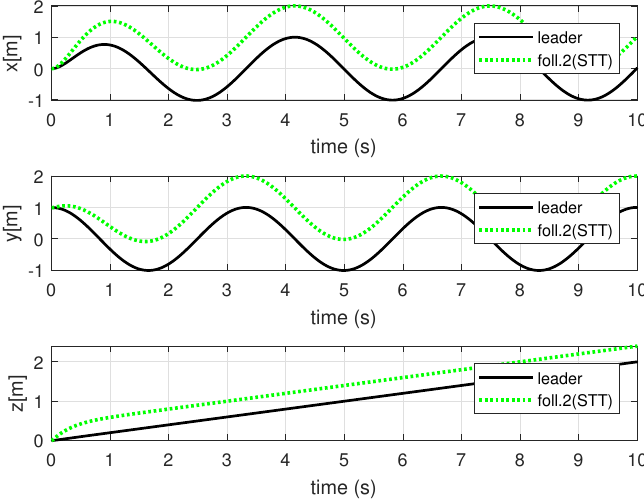
Figure 17. The results of the comparison simulation for the formation control of the second follower quadrotors about the 6 π circular trajectory: the solid line indicates the results of leader quadrotor; the green dashed line is the result of the proposed formation control with the state transformation technique